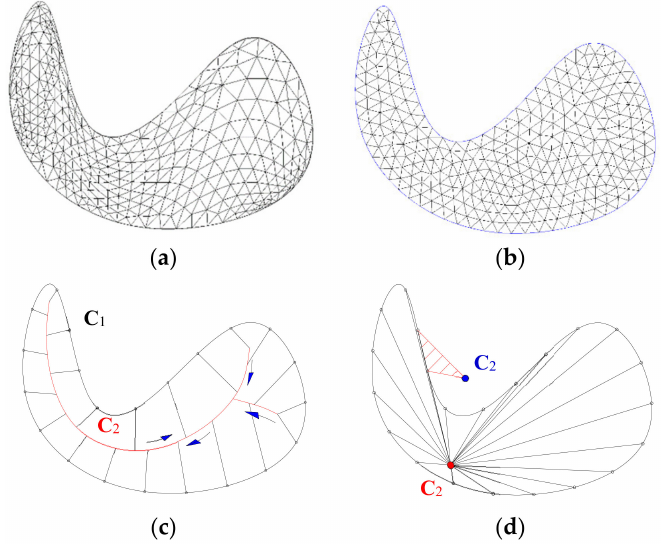
Figure 6. ( a ) Hybrid triangle mesh; ( b ) paver triangle mesh; ( c ) homotopic mesh; ( d ) homotopic mesh in point